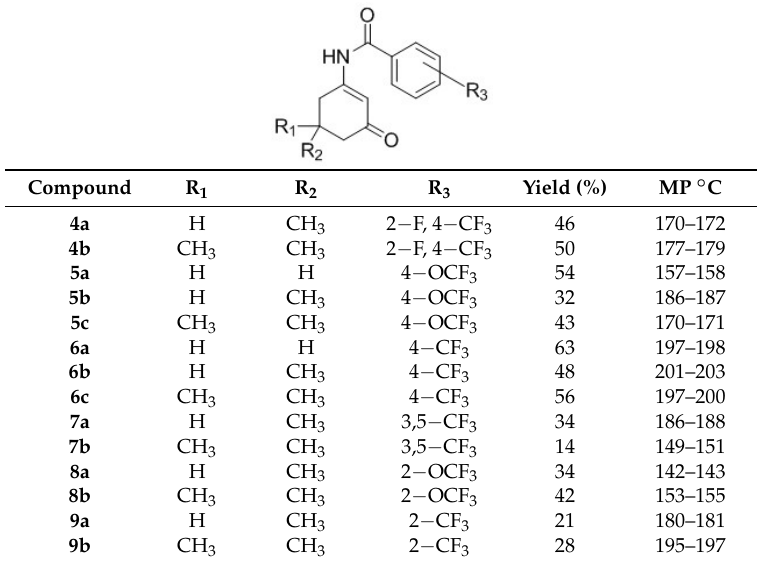
Table 1. Chemical properties of fluorinated n-benzamide enaminones.